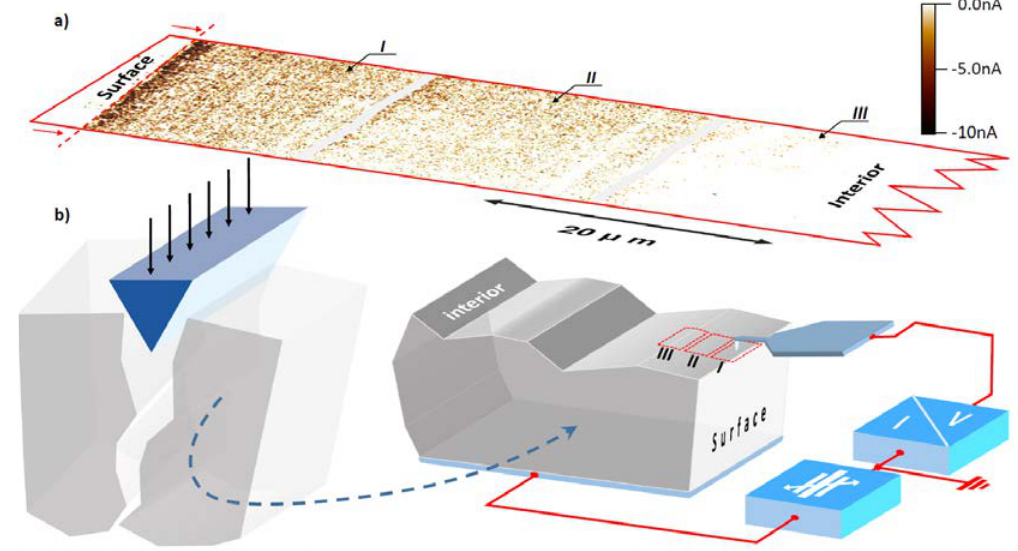
Figure 43. Distribution of the conducting filaments in the surface region in the reduced SrTiO 3 crystals revealed by LCAFM mapping ( a ) of the cleaved crystal. The distribution of the conducting filaments shows a similarity to the hierarchical distributions of dislocations, which have been analyzed using TEM technique (see Figure 18). The cleaving of the reduced crystal was obtained at RT in situ (in 4%H 2 in Ar) ( b ).